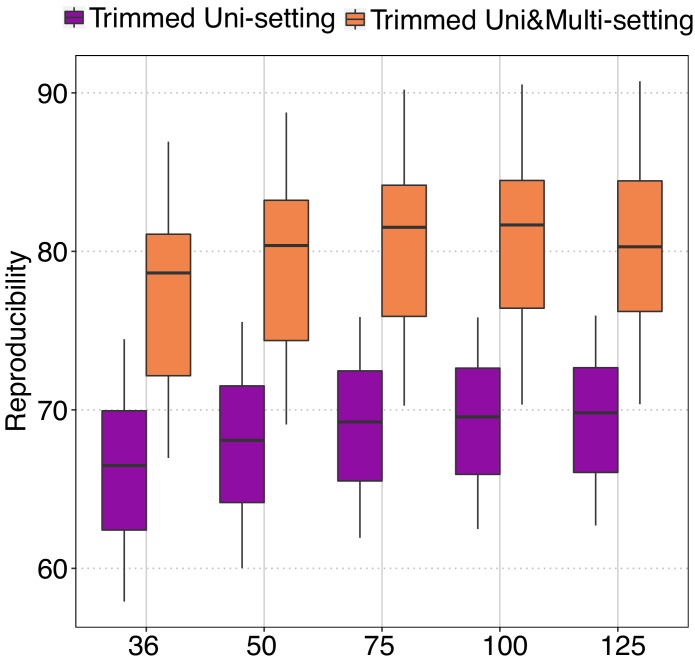
Reproducibility of trimmed Uni-setting and trimmed Uni&Multi-setting across different read lengths at 40 kb resolution.